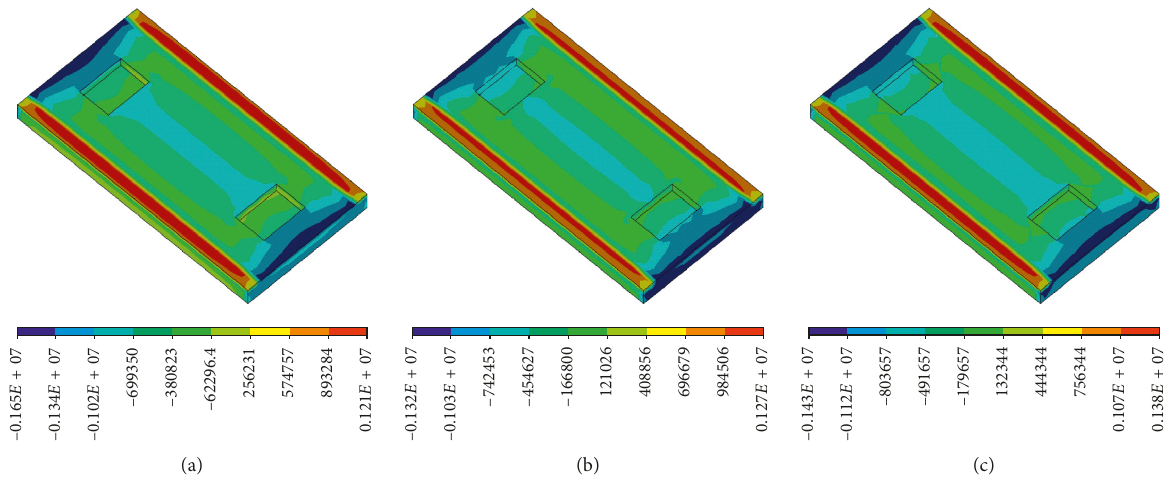
Figure 21: Transverse stress of the bed plate under condition 2. (a) P